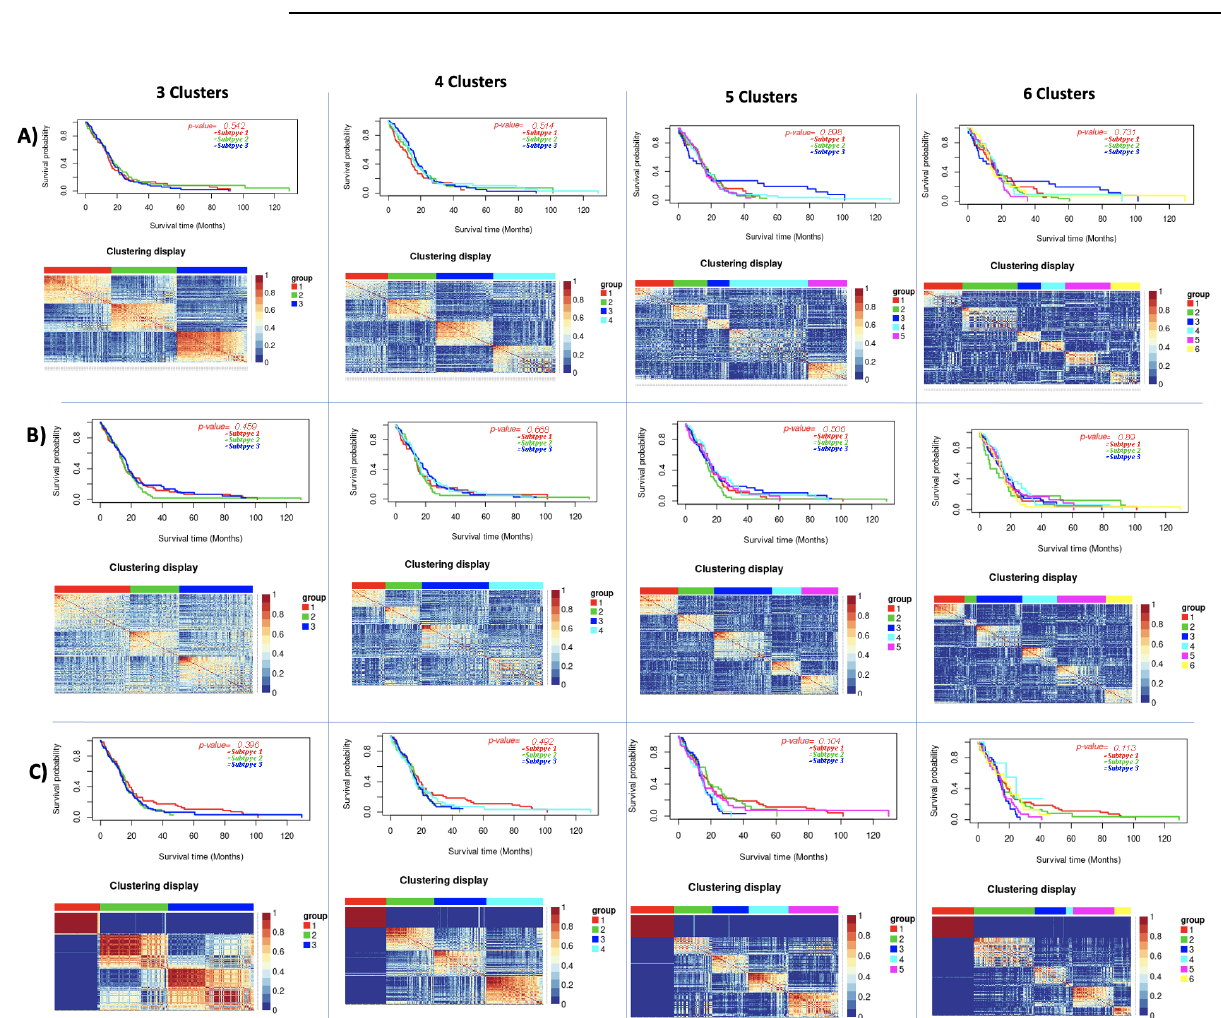
Figure 5. Principal component analysis results: ( A ) Principal Component Analysis (PCA) Results; ( B ) Kernel Principal Component Analysis (KPCA) Results; and ( C ) Sparce Principal Component Analysis (SPCA). Results In each subfigure, ( Top ): Kaplan-Meier survival curves of the identified clusters. ( Down ): Patient to patient similarity and identified clusters on the